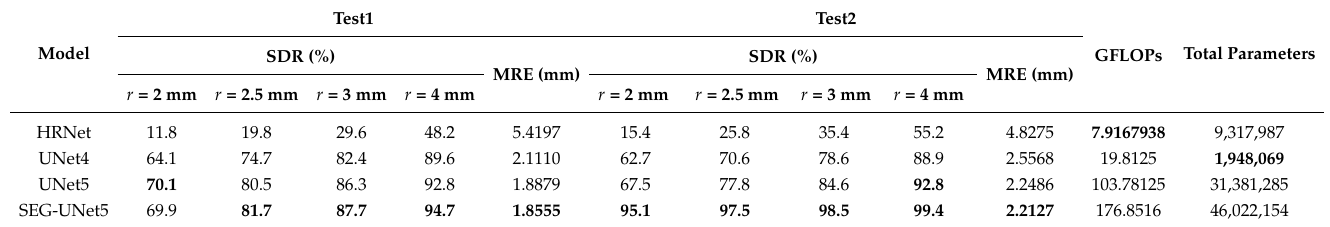
Table 2. 2D hip radiograph dataset: The comparison results for our proposed improving-teacher method on the 2D hip radiograph dataset. The student model is UNet4, while the teacher model is UNet5 and SEG-UNet5.